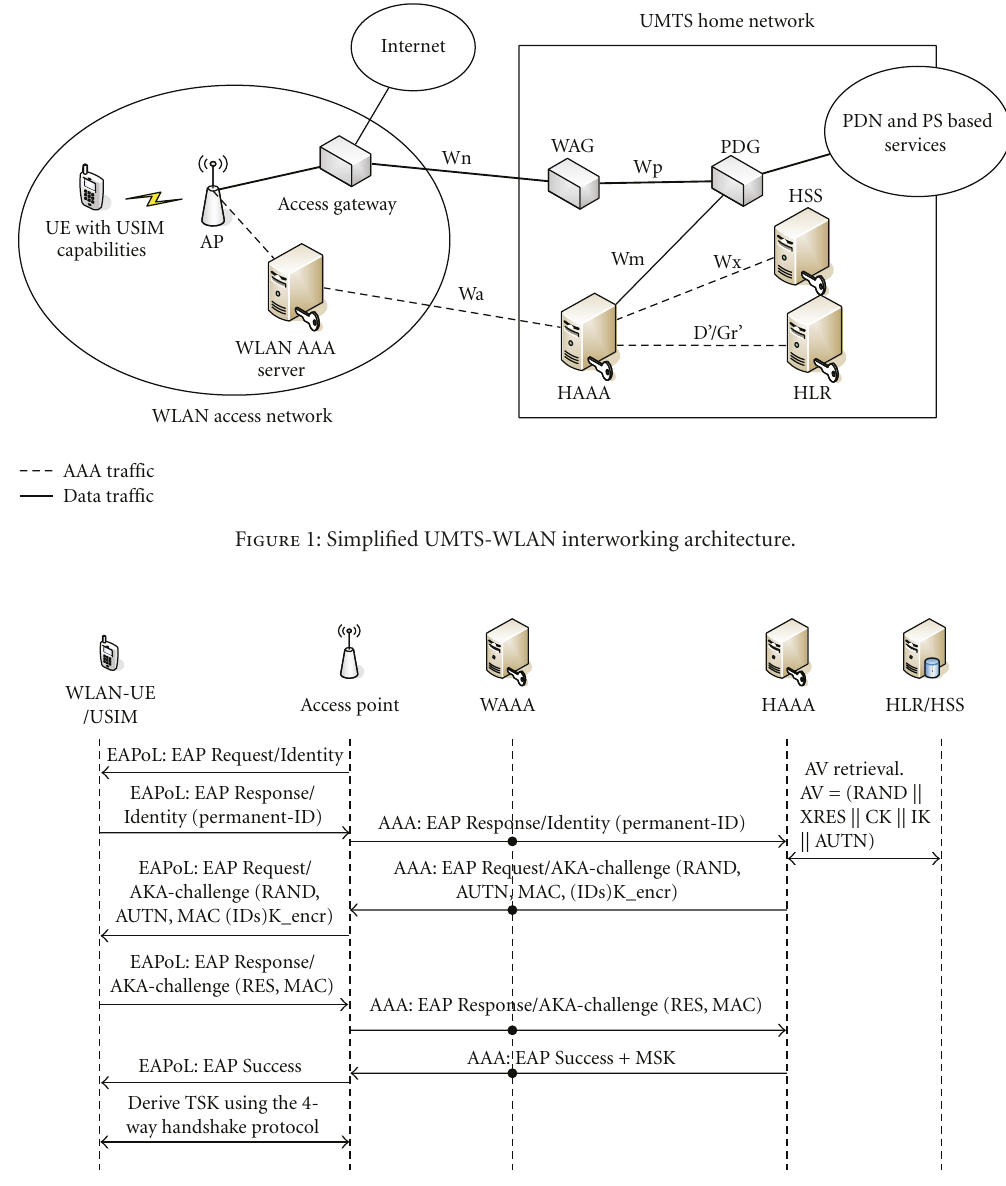
Figure 2: EAP-AKA authentication